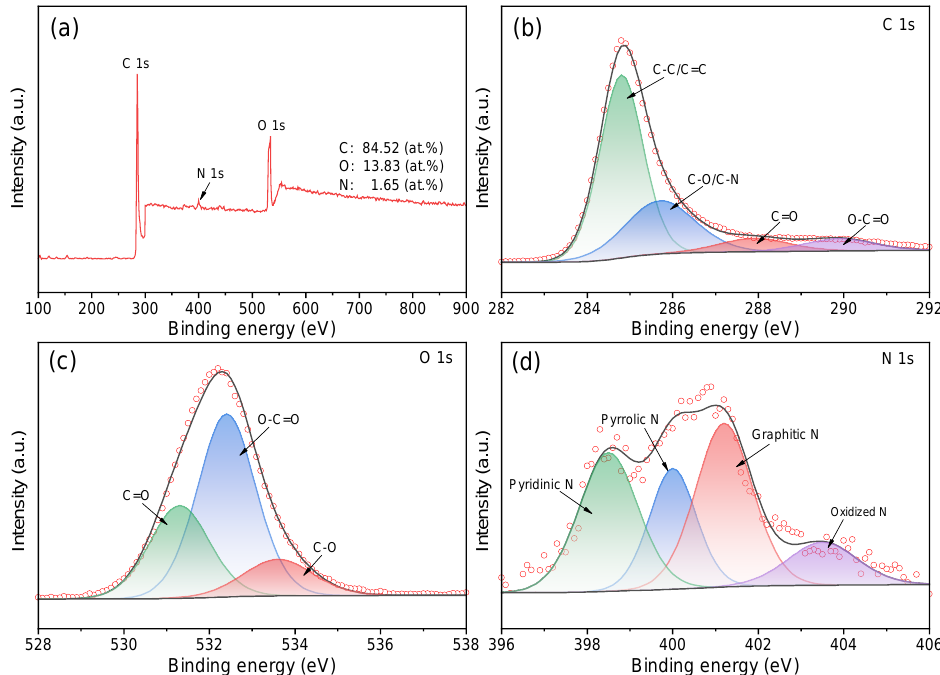
Figure 3. ( a ) XPS full survey spectrum and the high resolution deconvoluted ( b ) C 1s, ( c ) O 1s, and ( d ) N 1s spectra for